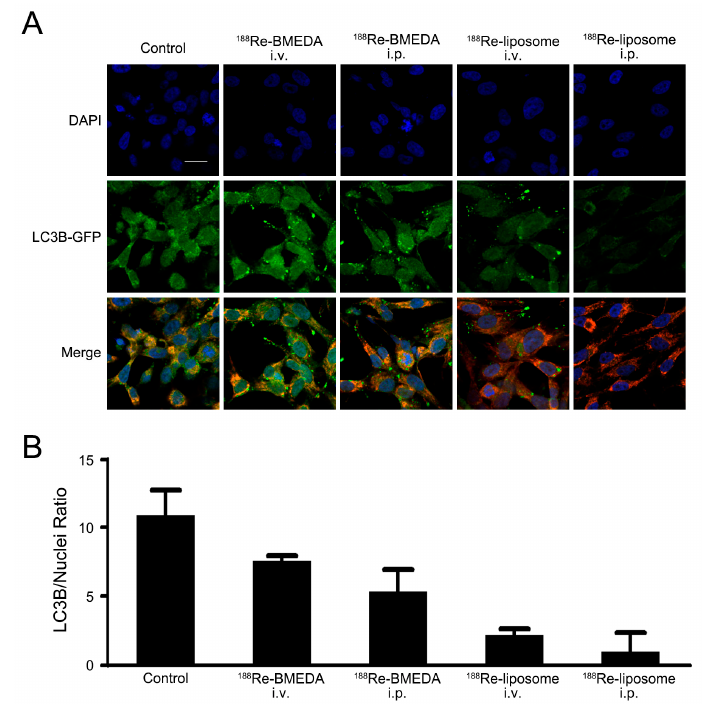
Figure 3. Intraperitoneal delivery of 188 Re-liposome revealed a critical role in altering LC3B. ( A ) Images of live cells from primary cultures were taken by confocal microscopy. Treatment with 188 Re-liposome significantly suppressed the expression of LC3B in xenograft mice models. Representative data are shown, ( B ) each bar depicting the ratio of LC3B/nuclei from ( A ). Data are presented as the mean ± SD with at least triplicates. DAPI, 4 ′ ,6-diamidino-2-phenylindole; GFP, Green fluorescent protein; LC3B, microtubule-associated protein 1 light chain 3B. Scale bar represents 20 µ m.